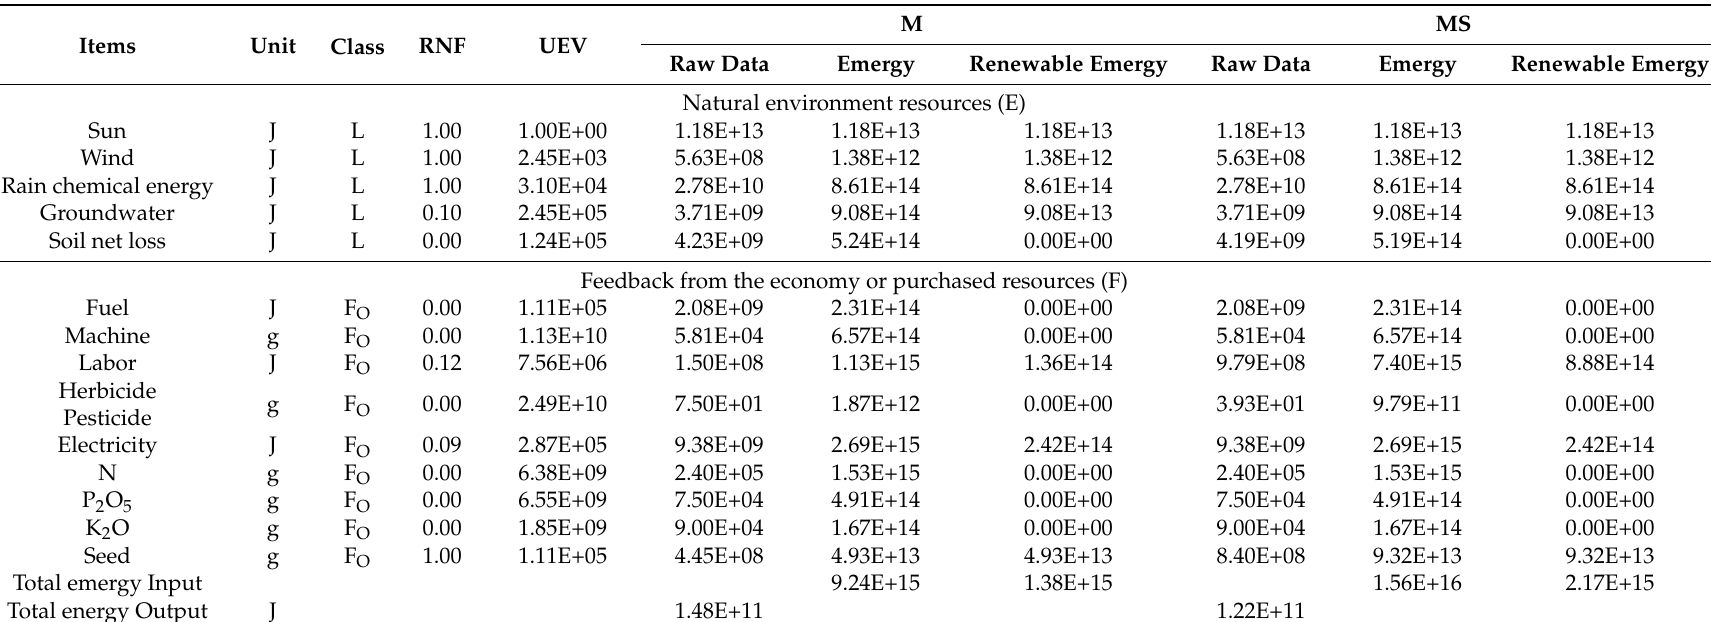
Table 4. Emergy analysis table of the cropping system (g/J ha − 1